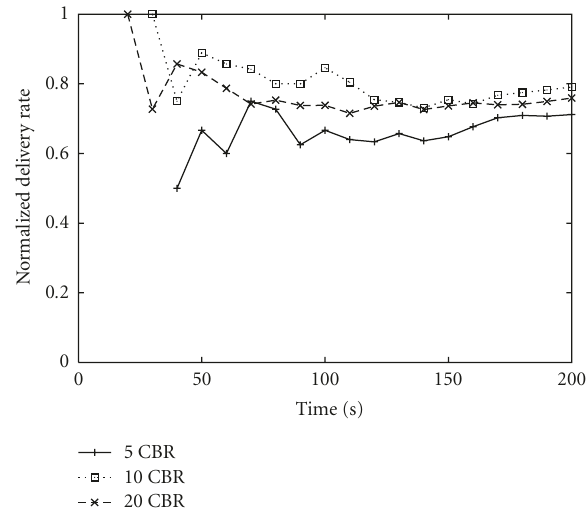
Figure 16: The influence of tra ffi c in AODV performance using the bounce